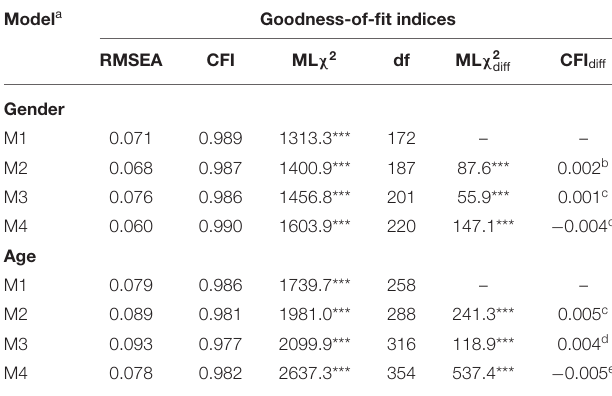
TABLE 1 | Standardized factor loadings of the 15-item Interpersonal Acceptance-Rejection Loneliness Scale. Item